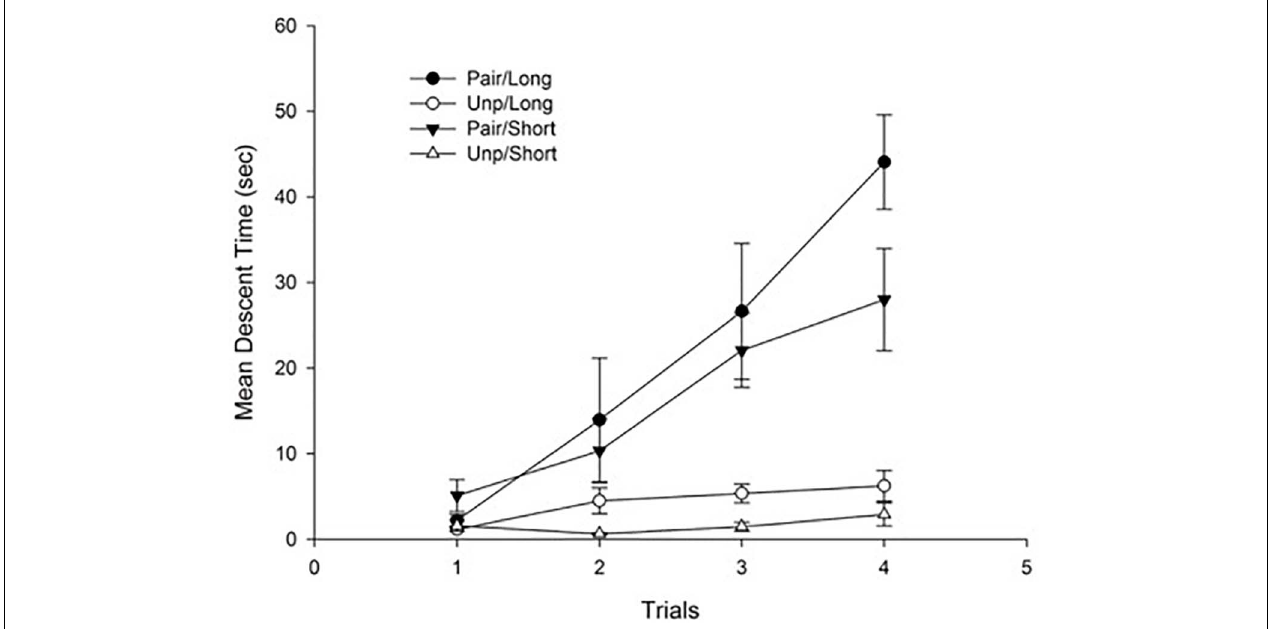
FIGURE 1 | Mean descent latency for conditioning trials as a function of Groups. Pair: Paired; Unp: Unpaired. Error bars represent standard error of the mean (SEM)s.